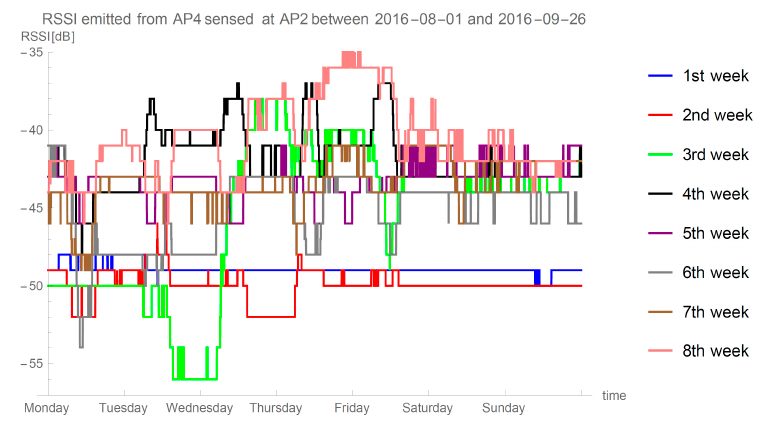
Figure 5. RSSI variance in long term experiment.